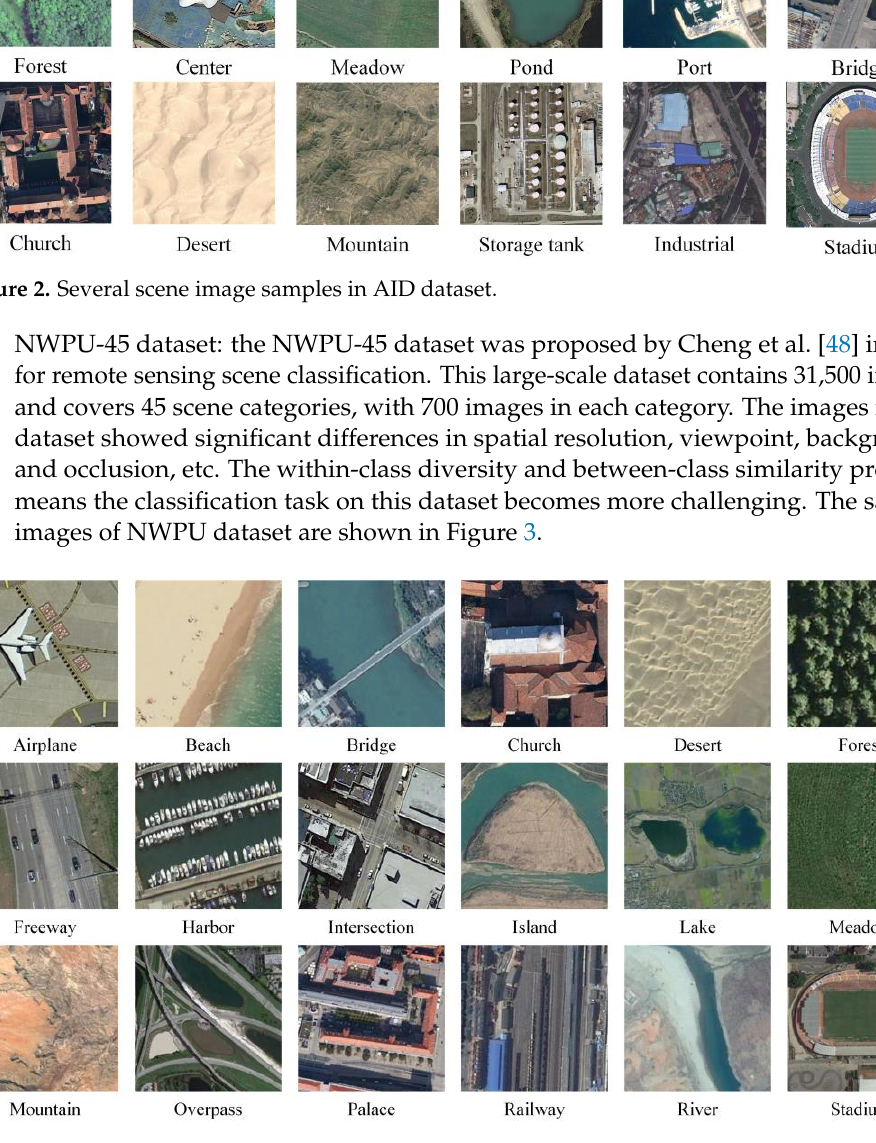
Figure 4. Several scene image samples on RSI dataset. 4.2. Experiments Setup For continual learning across different datasets, we set the AID dataset as the first step of the scene classification task; the RSI-CB256 and NWPU-45 datasets were subse- quently added in the second and third steps of the task, respectively. As can be seen in Figure 5, it is a challenging task to perform continual learning across different domain datasets. We split the labeled samples of three datasets into the labeled supervised train- ing set, unlabeled contrastive learning, and testing set. In order to simulate the data